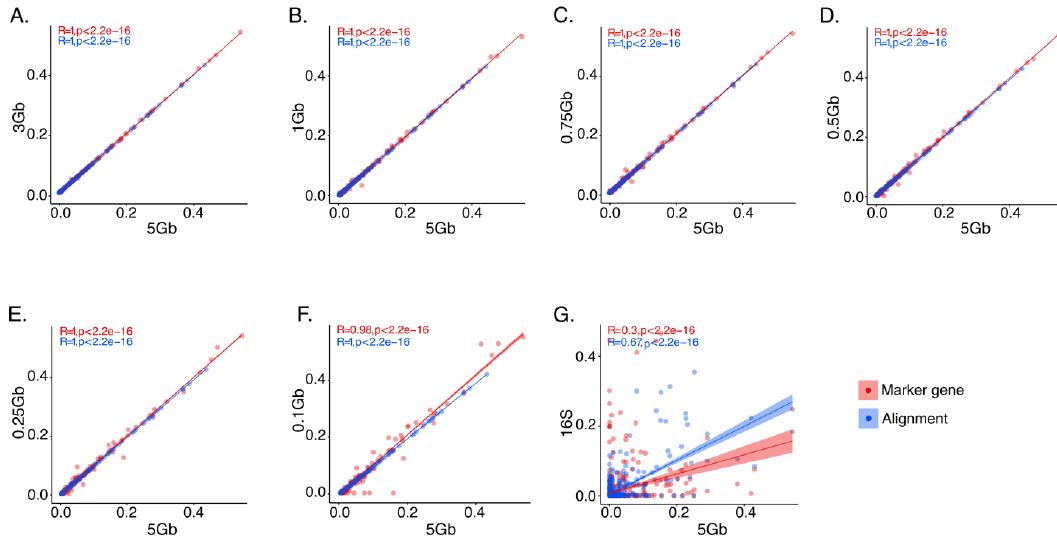
Figure 4. Correlation plots of the relative abundances of bacterial genera annotated using marker gene-mapping and alignment methods. ( A ) Correlations performed with data obtained at 5 Gb (16.67 M reads) vs. 3 Gb (10.00 M reads). ( B ) Correlations performed with data obtained at 5 Gb vs. 1 Gb (3.00 M reads). ( C ) Correlations performed with data obtained at 5 Gb vs. 0.75 Gb (2.50 M reads). ( D ) Correlations performed with data obtained at 5 Gb vs. 0.5 Gb (1.65 M reads). ( E ) Correlations performed with data obtained at 5 Gb vs. 0.25 (0.85 M reads). ( F ) Correlations performed with data obtained at 5 Gb vs. 0.1 Gb (0.35 M reads). ( G ) Correlations performed with data obtained at 5 Gb vs. 16S sequencing data.